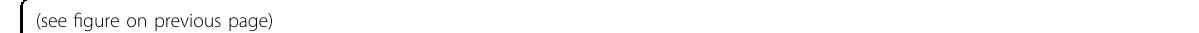
Fig. 5 Bulk RNA-seq analysis of cells sorted by surface marker. a In situ hybridization of E16.5 mouse embryo showing dermis. eYFP , Pdgfra, and Thy1 signals were observed at dermis while only DAPI (blue color) was observed at epidermis. b Section staining of E16.5 mouse embryo showing dermis. eYFP, Pdgfra, and Crabp1 signals were observed at dermis while only DAPI (blue color) was observed at epidermis. c Section staining of E16.5 mouse embryo showing muscle fi ber and brown adipose tissue. While DAPI and YFP signal were observed at both locations, muscle and brown adipose tissue were respectively stained by MF20 and Pparg antibodies. d In vitro culture assay of E14.5 YFP + cells sorted by the combination of Pdgfra and Thy1 antibodies. Scale bar, 100 µm. e Bar plot of Oil Red O intensity between cultured samples. Student ’ s t -test was performed between two culture conditions. Values are means ± SEM, n = 3; ns not signi fi cant, *** P < 0.001. f Culture schematic and RT-qPCR result of E14.5 Pdgfra + /Thy1 − cells (LP) before and after TGF β 1 ligand treatment. Two-way ANOVA was performed followed by Dunnett ’ s multiple comparisons test. Values are means ± SEM, n = 3; ns, not signi fi cant; ** P < 0.01,*** P < 0.001, **** P < 0.0001. g Venn diagrams of highly variable gene sets between sorted and cultured samples. Highly variable genes between two populations were selected. Key genes found in the corresponding sets are listed. Genes with normalized expression data > 0.3 were kept as set in the